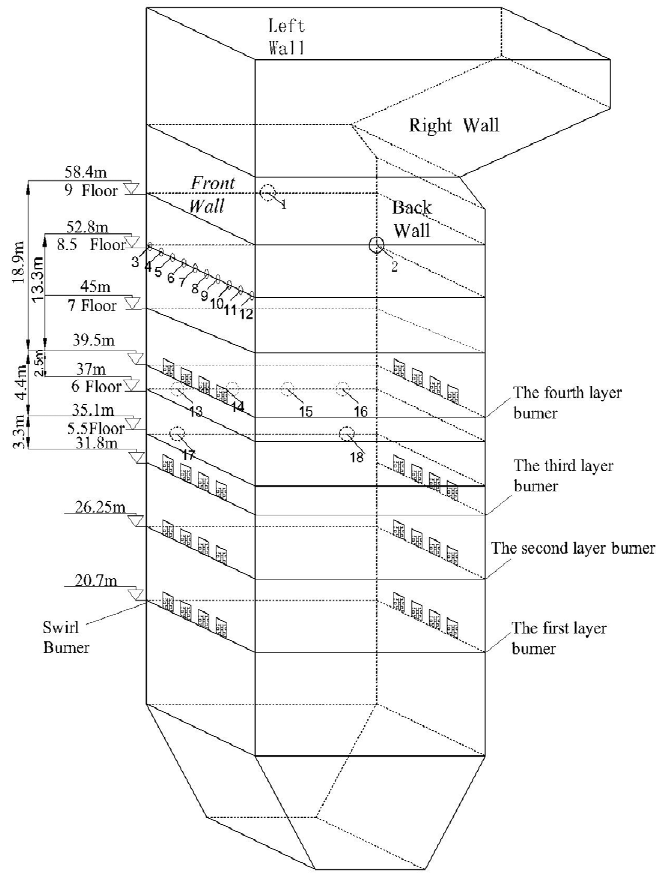
Figure 7. Schematic diagram of the furnace and locations of measuring points in the 1000 MW unit.